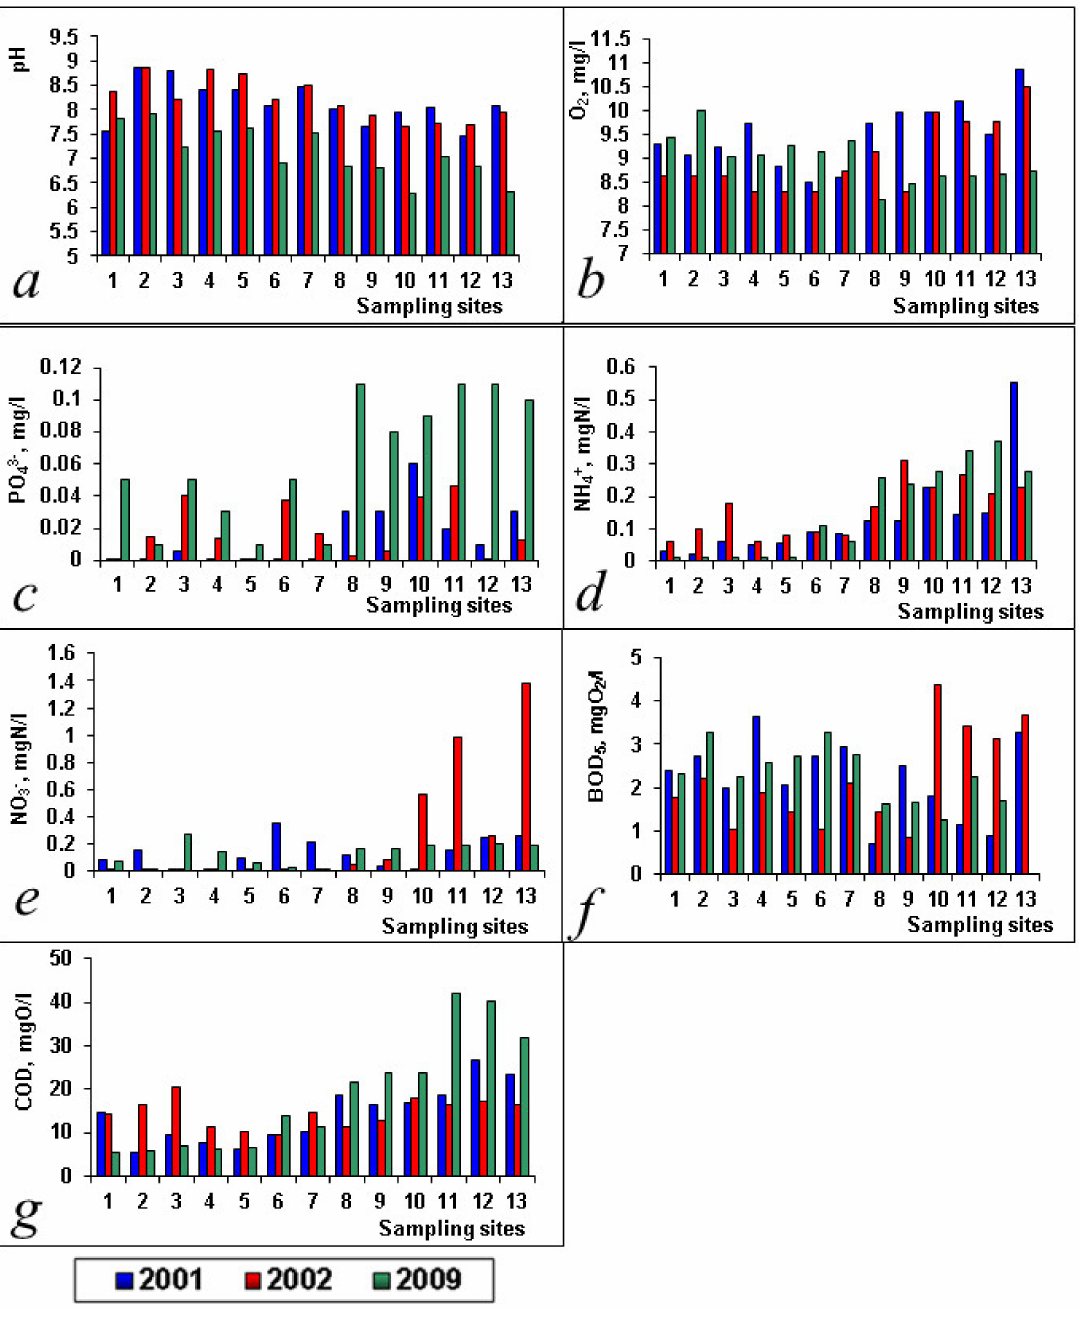
Figure 5. Long-term variations in hydrochemical parameters (in August) of the Middle and Low Ob River in investigated sites (sites numbers correspond to those specified in Table 1). ( a )—pH; ( b )—O 2 ; ( c )–PO 4 3 − ; ( d )–NH 4 + , ( e )–NO 3 − ; ( f )–BOD 5 ; ( g